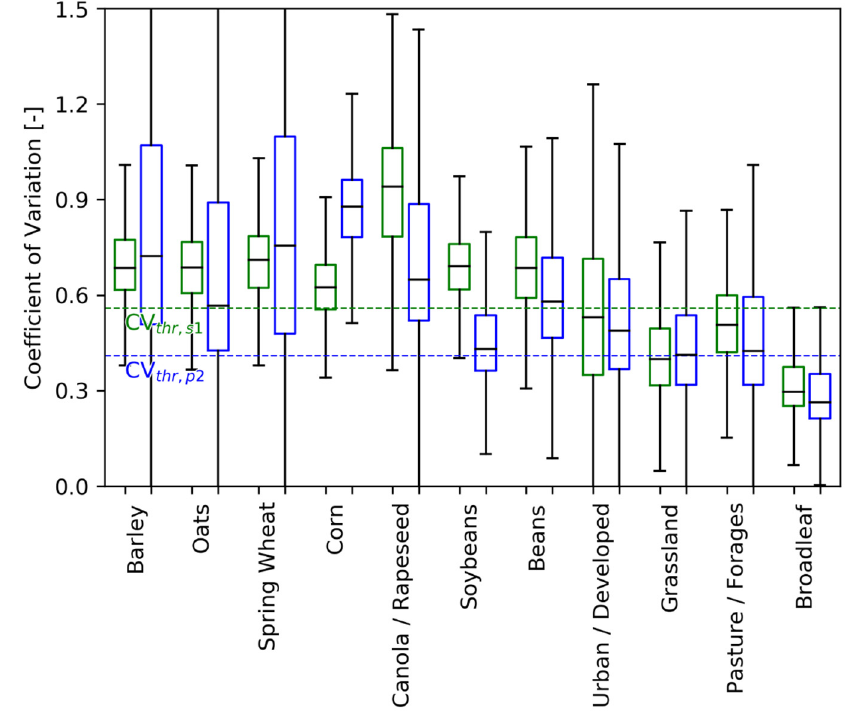
Figure 7. Boxplot showing the median (horizontal bar inside each box) and the interquartile range of the Sentinel-1 and PALSAR-2 CV data of all ACI land cover classes with prevalence >2%. The IRQ is the difference between the 75th (Q3) and 25th (Q1) percentile value (the upper and lower bounds of the box) and whiskers extend 1.5*IQR above and below Q3 and Q1. Median CV values of most crops (non-crops) are above the respective CV thr value, indicating good (poor) classification accu- racy.